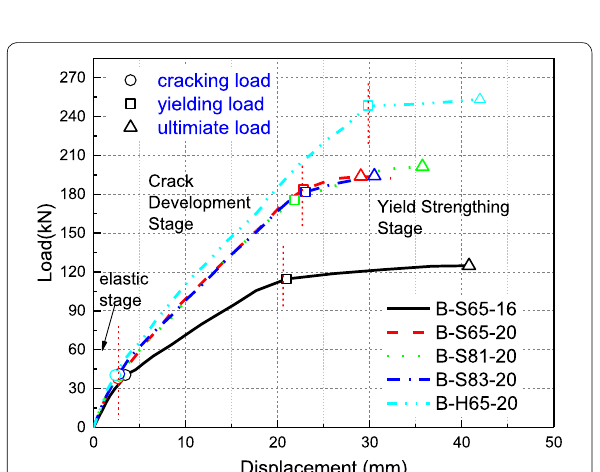
Fig. 10 Load mid-span displacement curves of the